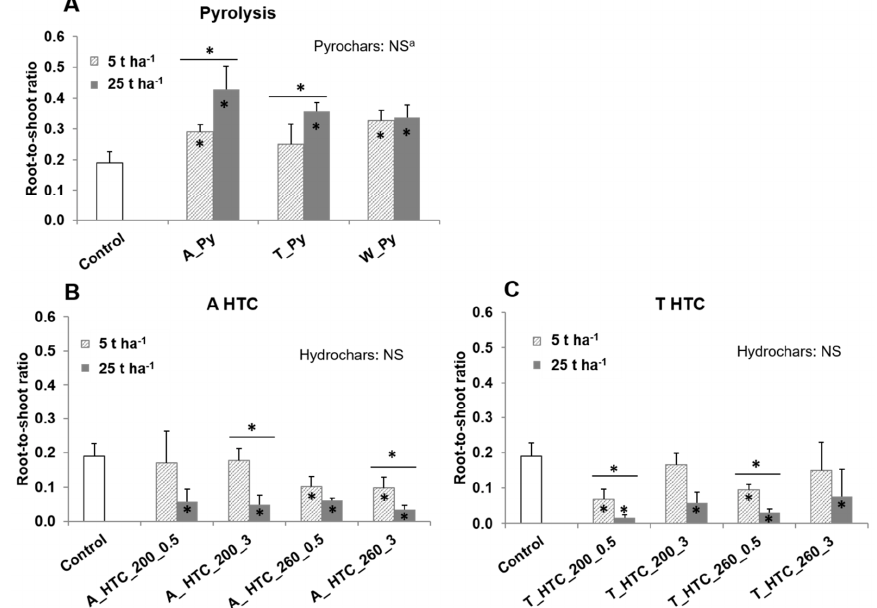
Figure 4. Root-to-shoot ratio of Lolium perenne in: ( A ) Control and pyrochars-amended pots, ( B ) Control and pots amended with hydrochars derived from A_SS and ( C ) Control and pots amended with hydrochars derived from T_SS. Hydrochars were produced from primary (A_) and secondary (T_) sewage sludges at 200 °C (_HTC_200) and 260 °C (_HTC_260) for 0.5 and 3 h (_0.5, _3, respectively). Pyrochars were produced from primary (A_) and secondary (T_) sewage sludges (_Py). NS: no significance. Asterisks inside the bars show significant differences with the control according to the t -test. The above-line asterisks indicate significant differences among doses according to the t